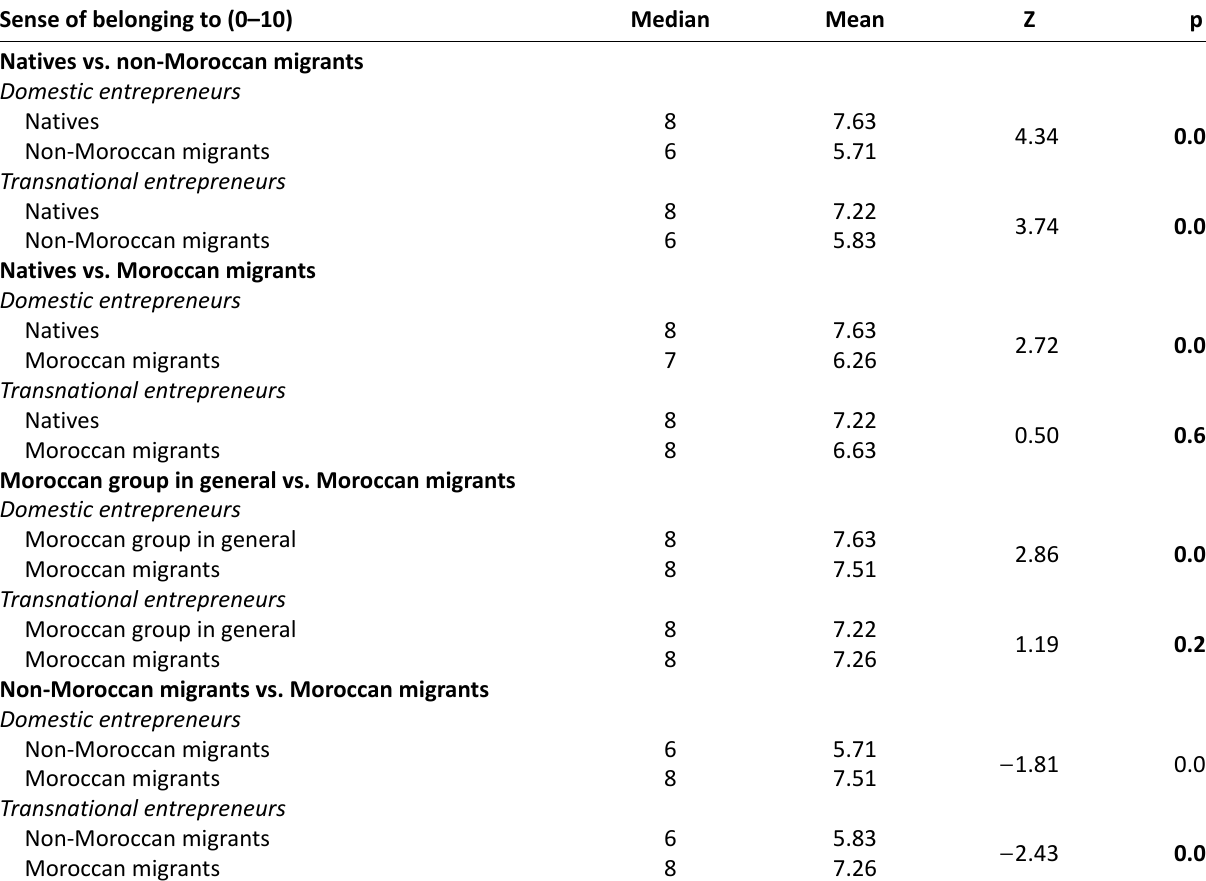
Table 3. Comparison between the sense of belonging towards different groups. Sense of belonging to